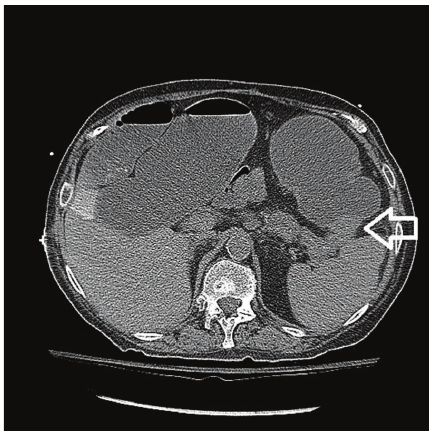
Figure 5: CT abdominal/pelvis obtained after repeat colonoscopy negative for intraluminal obstruction and return of abdominal distention and increase of abdominal pain. Question of pancreatic colonic fistula.